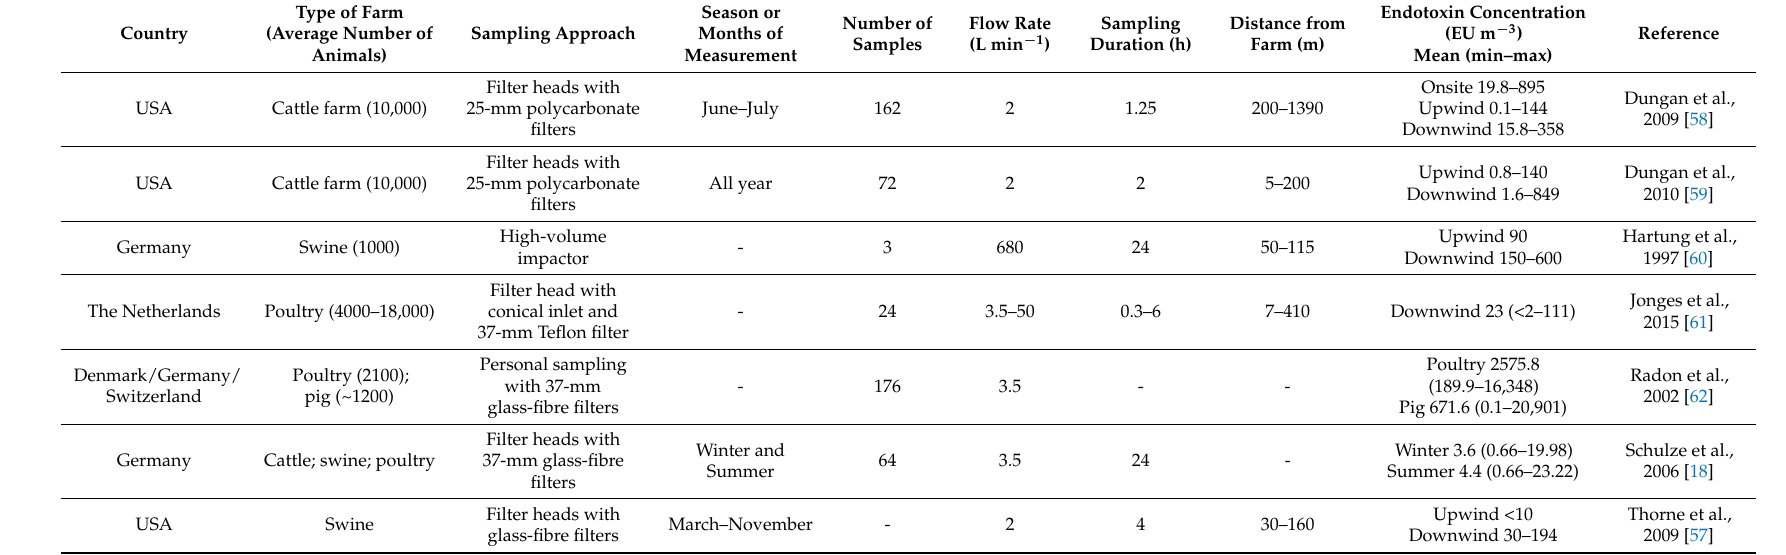
Table 3. Endotoxin emissions from intensive farming as reported in the